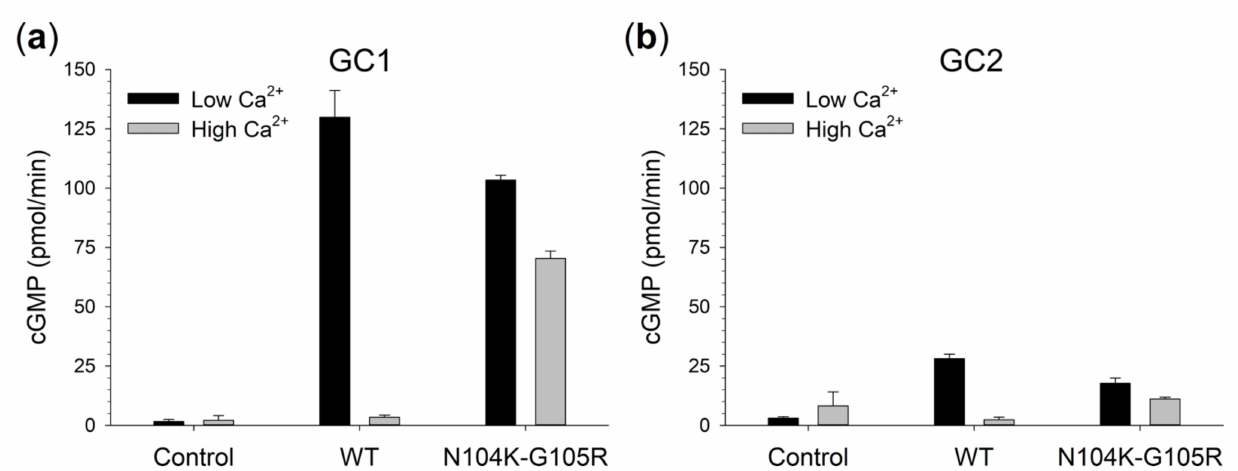
Figure 3. Regulation of guanylate cyclases by GCAP1 variants. Enzymatic regulation of ( a ) human GC1 and ( b ) human GC2 by 5 µ M GCAP1 WT and N104K-G105R variants in activating (low Ca 2+ , <19 nM) and inhibiting conditions (high Ca 2+ , ~30 µ M). Presented data are an average ± SD of 3 independent